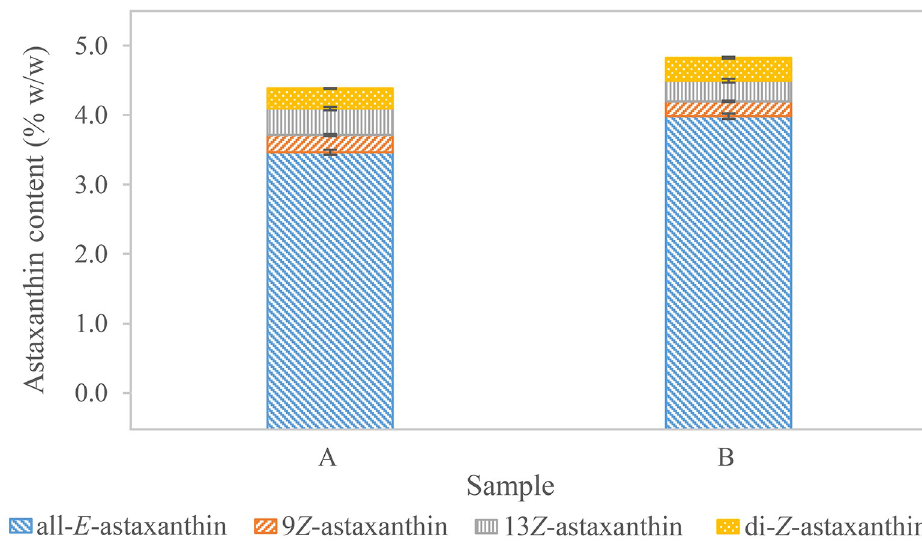
Fig 6. Astaxanthin content in two H . pluvialis powders. Standard deviation is indicated for each astaxanthin diastereomer. Sample A: n = 5, sample B: n = 4.